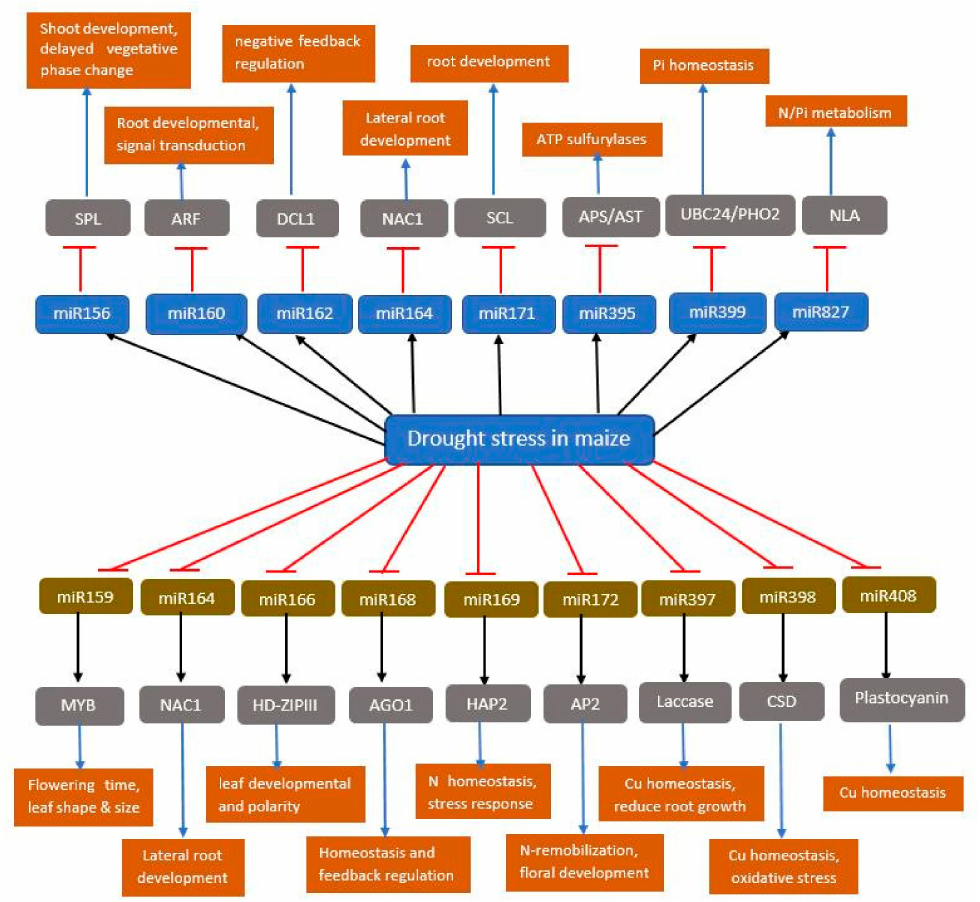
Figure 5. The miRNAs-guided target gene regulations under drought stress in maize. miRNAs that are positively regulated by drought stress (black arrow and blue rectangle) target negative regulators (top gray rectangle) of stress tolerance for enhanced suppression (red blunt arrow) of target gene products. By contrast, miRNAs that are suppressed by drought stress (red blunt arrow and gold rectangle) likely target positive regulators (bottom gray rectangle) of stress tolerance resulting in the accumulation of gene products (orange rectangle) which regulate drought stress response. SPL, sporocyteless; ARF, auxin response factor; DCL1, dicer like protein; NAC1, no apical meristem; SCL, scarecrow-like 3; APS, ATP sulfurylase; UBC24 / PHO2, ubiquitin-conjugating Enzyme E2 / phosphate 2; NLA, nitrogen limitation adaptation; MYB, myeloblastosis; HD-ZIP III, homeodomain-leucine zipper 3; HAP2, heme activator protein 2; AP2, apetala 2; CSD, copper / zinc superoxide